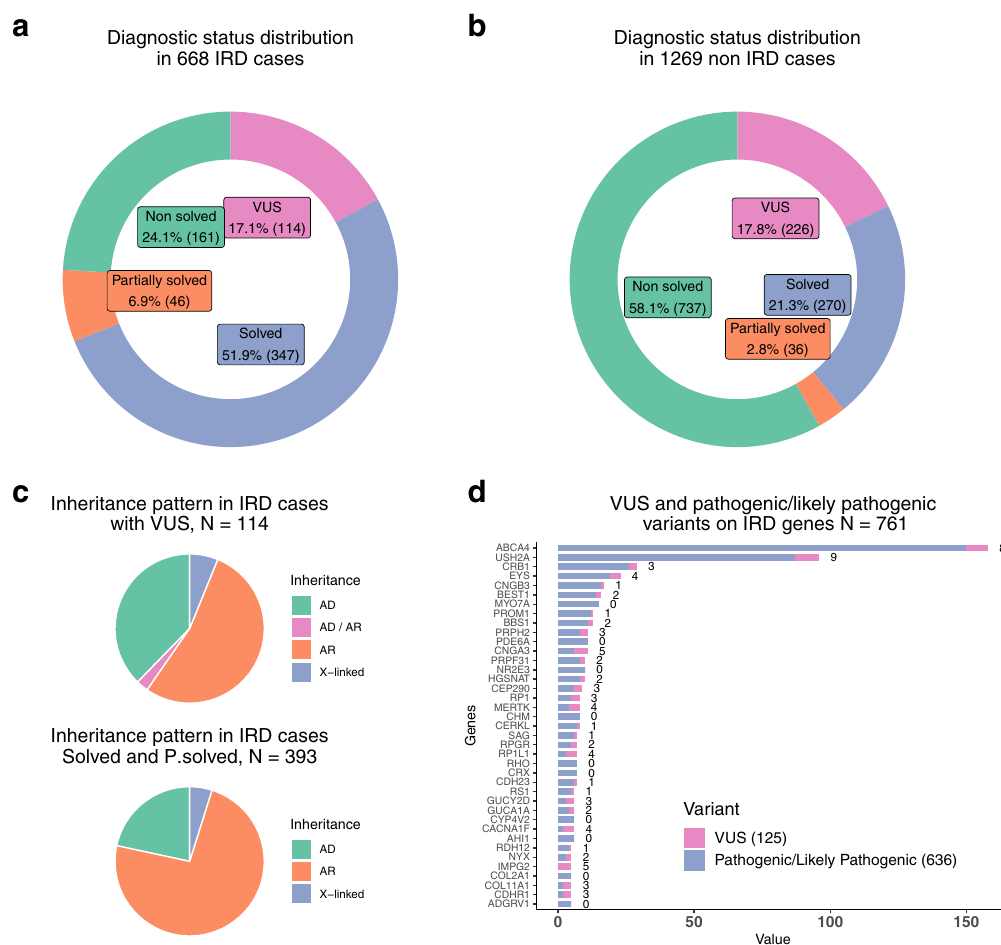
Fig. 1 Diagnosis, inheritance, and gene distribution. VUS reporting frequency for IRD ( a ) and non-IRD cases ( b ). For IRD, the inheritance pattern was compared for solved and partially solved cases versus VUS cases ( c ). Four VUS cases have not been included in the plot since an inheritance pattern has not been established for them. ( d ) VUS (number appearing beside VUS diagnoses for each gene) and pathogenic/ likely pathogenic variants were compared on IRD